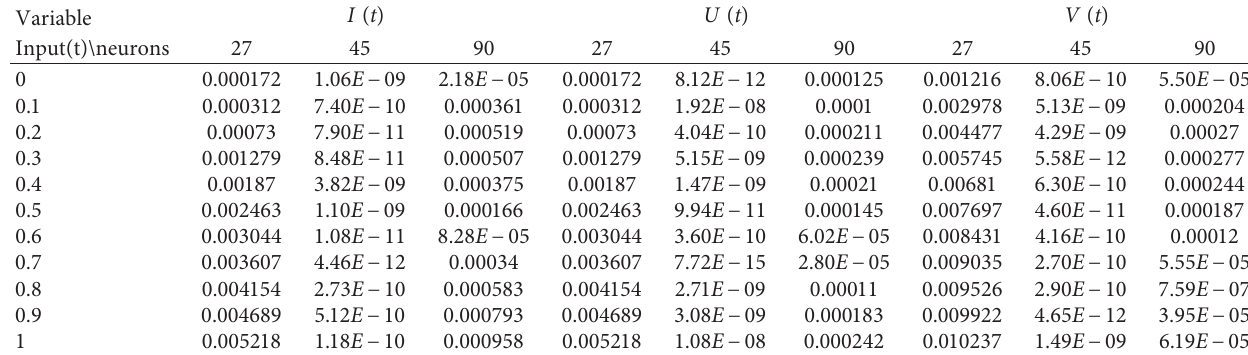
Table 10: Problem 3: analysis based on the variation of the number of